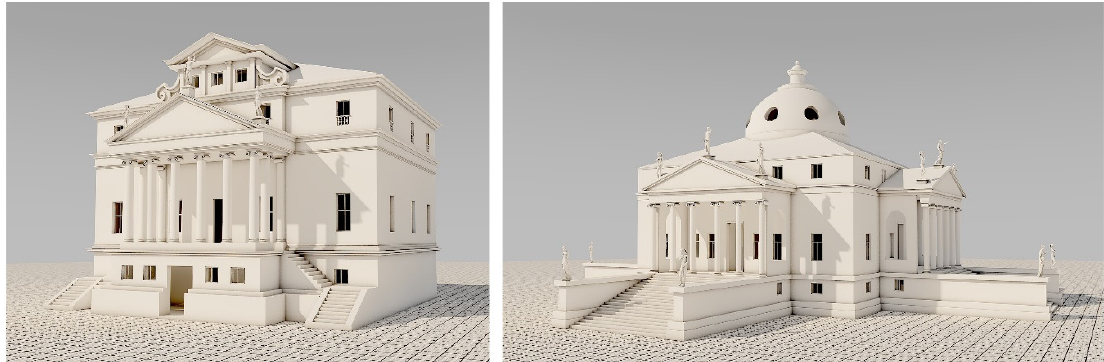
Figure 1. Perspective views of Palladio’s Villa Malcontenta ( left ) and Villa Rotonda ( right ).